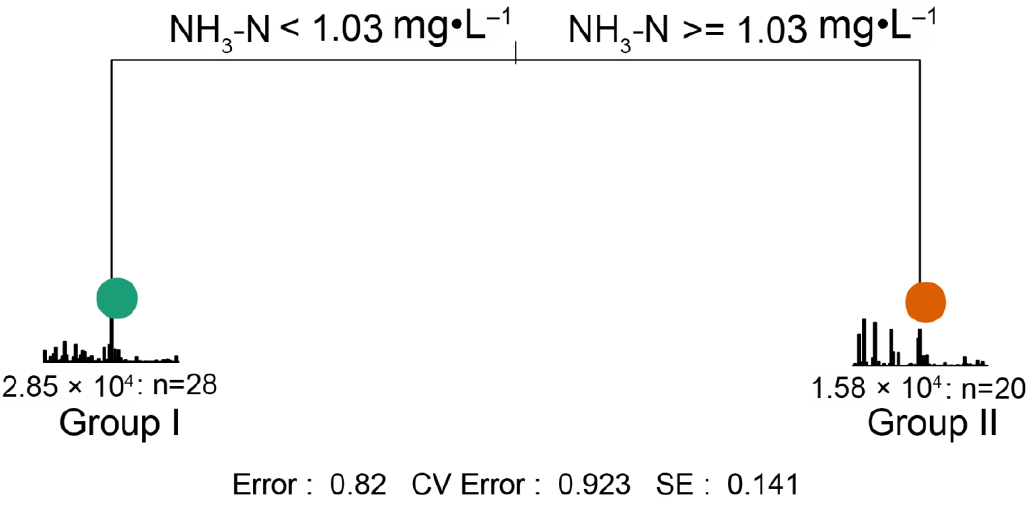
Figure 2. Dendrogram of multivariate regression tree classification based on zooplankton community structure in the rivers of Shanghai City.